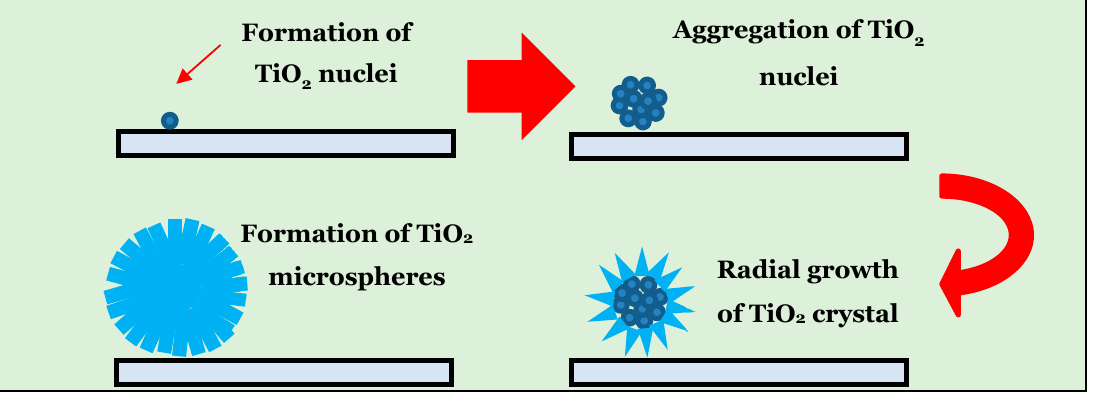
Figure 5. Growth mechanism of TiO 2 microsphere.